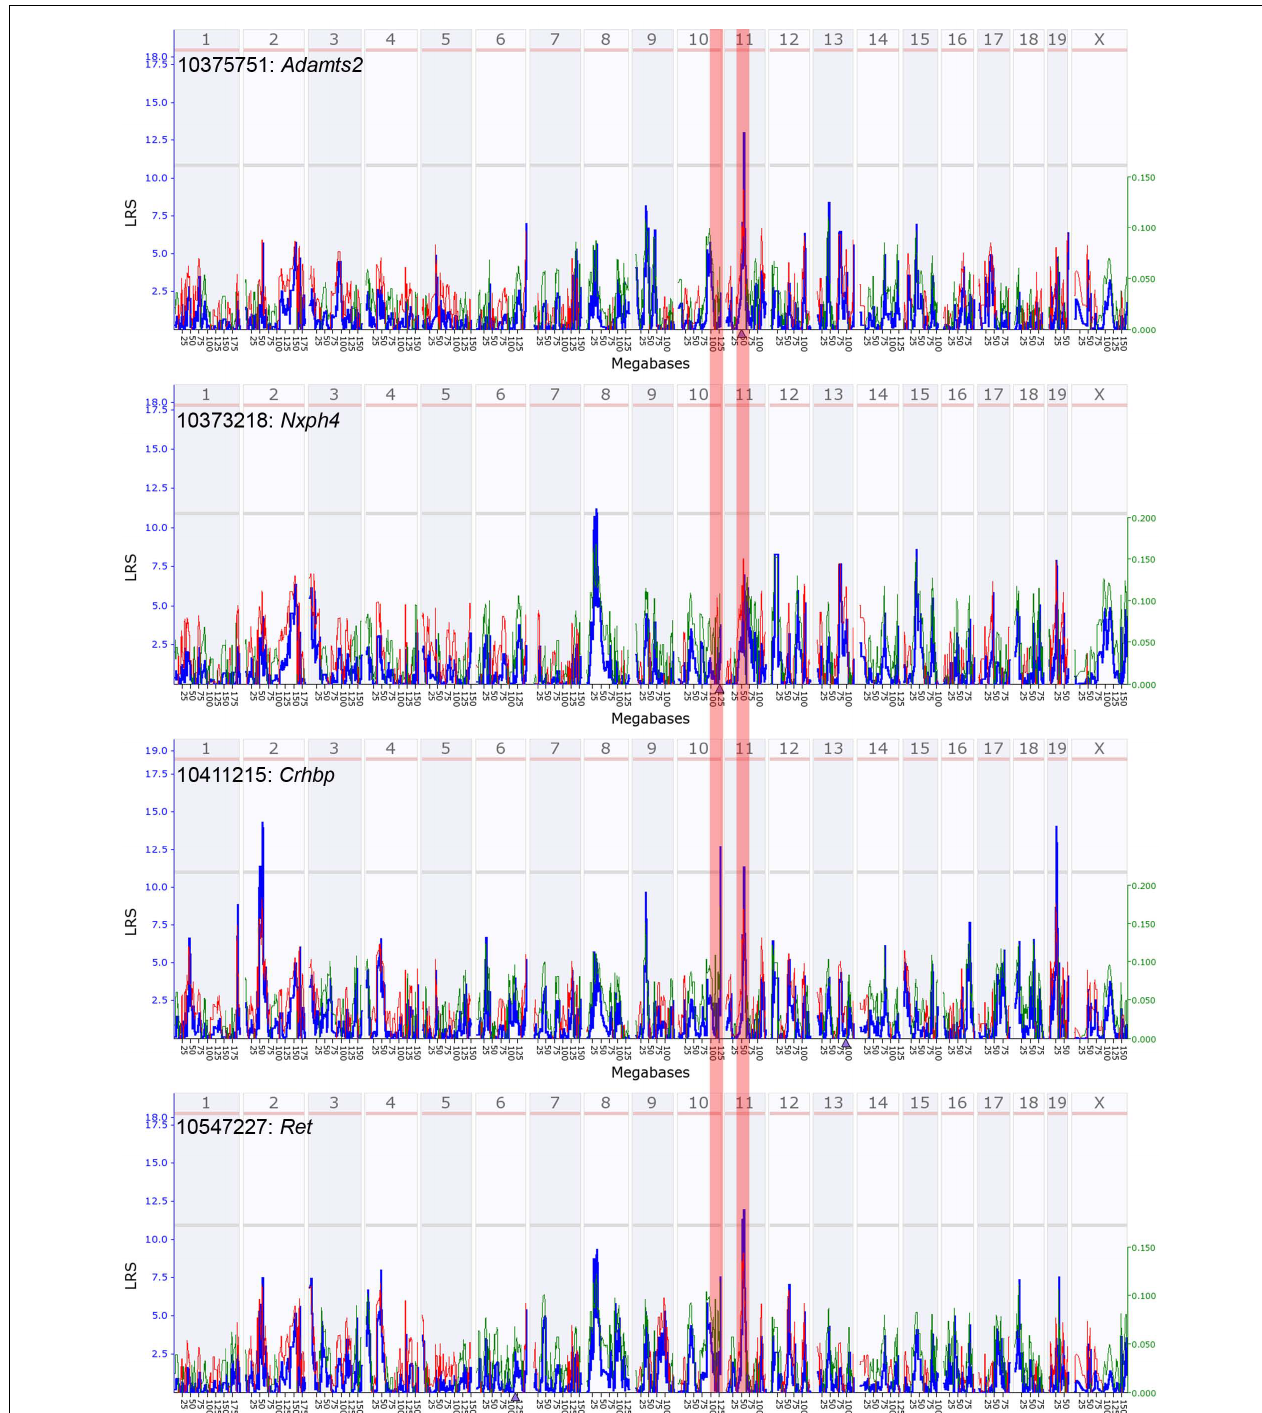
FIGUREA4 | Quantitative trait loci maps of M9 members in males. These are genome-wide QTL maps for M9 members – Adamts2 , Nxph4 , Crhbp , and Ret .The Adamts2 transcript has a suggestive cis- QTL on mid chromosome 11 (highlighted zone). Crhbp and Ret have suggestive trans -QTL on mid